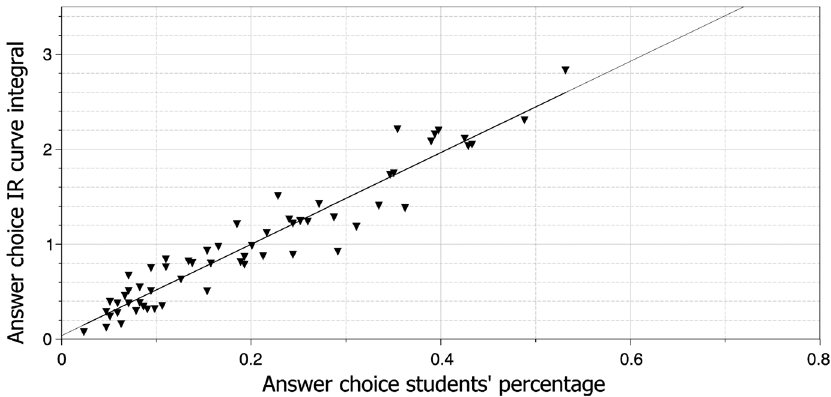
1. Correlation between the IRC integral of an answer choice and the percentage of students who picked it. Data in the plot are from the present study. The solid line shows a best fit to the data. The slope is 4 . 8 (cid:3) 0 . 2 , which approximates the range of student ’ scores measured in standard